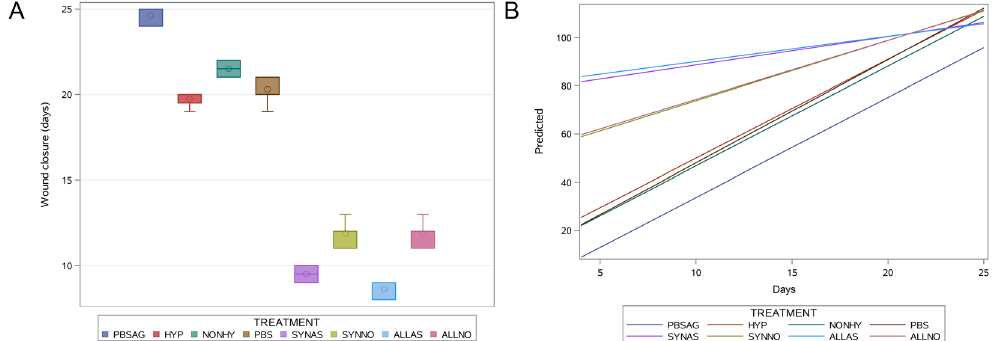
Figure 2. The wound healing: time to wound closure presented as a box plots ( A ), and regression analysis of wound reduction with predicted values of various treatment groups plotted versus time, expressed as days for various treatment options ( B ). SYNAS – young, syngeneic cells + AA, ALLAS – young, allogeneic cells + AA, SYNNO – young, syngeneic, non-preconditioned cells, ALLNO – young, allogeneic, non-preconditioned cells, PBS – control side young animals, HYP – adult, hypoxic, NONHY – adult, non-hypoxic, PBSAG – control side in adult animals. The boxes represent interval between 25 and 75 percentile, and whiskers the minimum and maximum